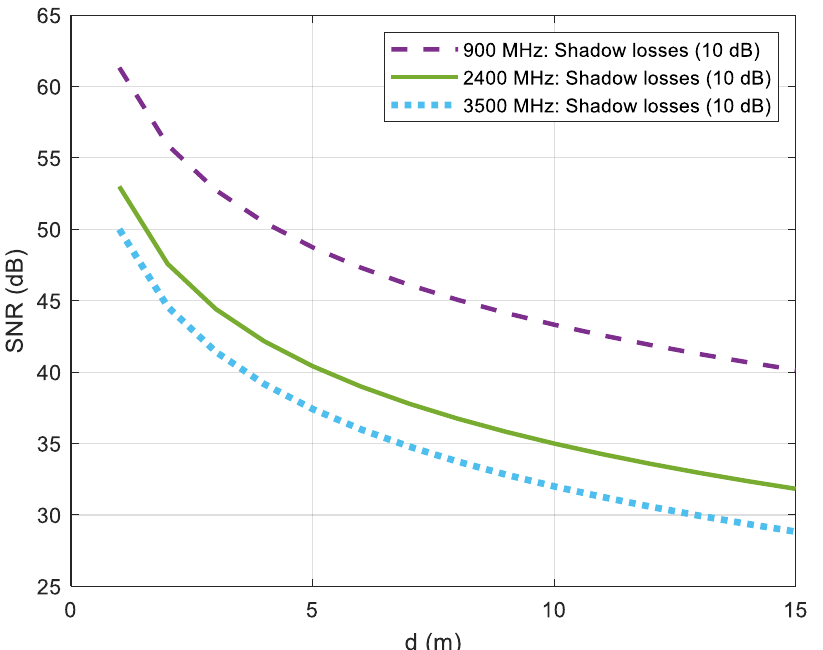
Figure 4. Signal-to-noise ratio (SNR) for wireless propagation in a room (15 m area) for a 10 dB shadow loss at 900, 2400, and 3500 MHz.